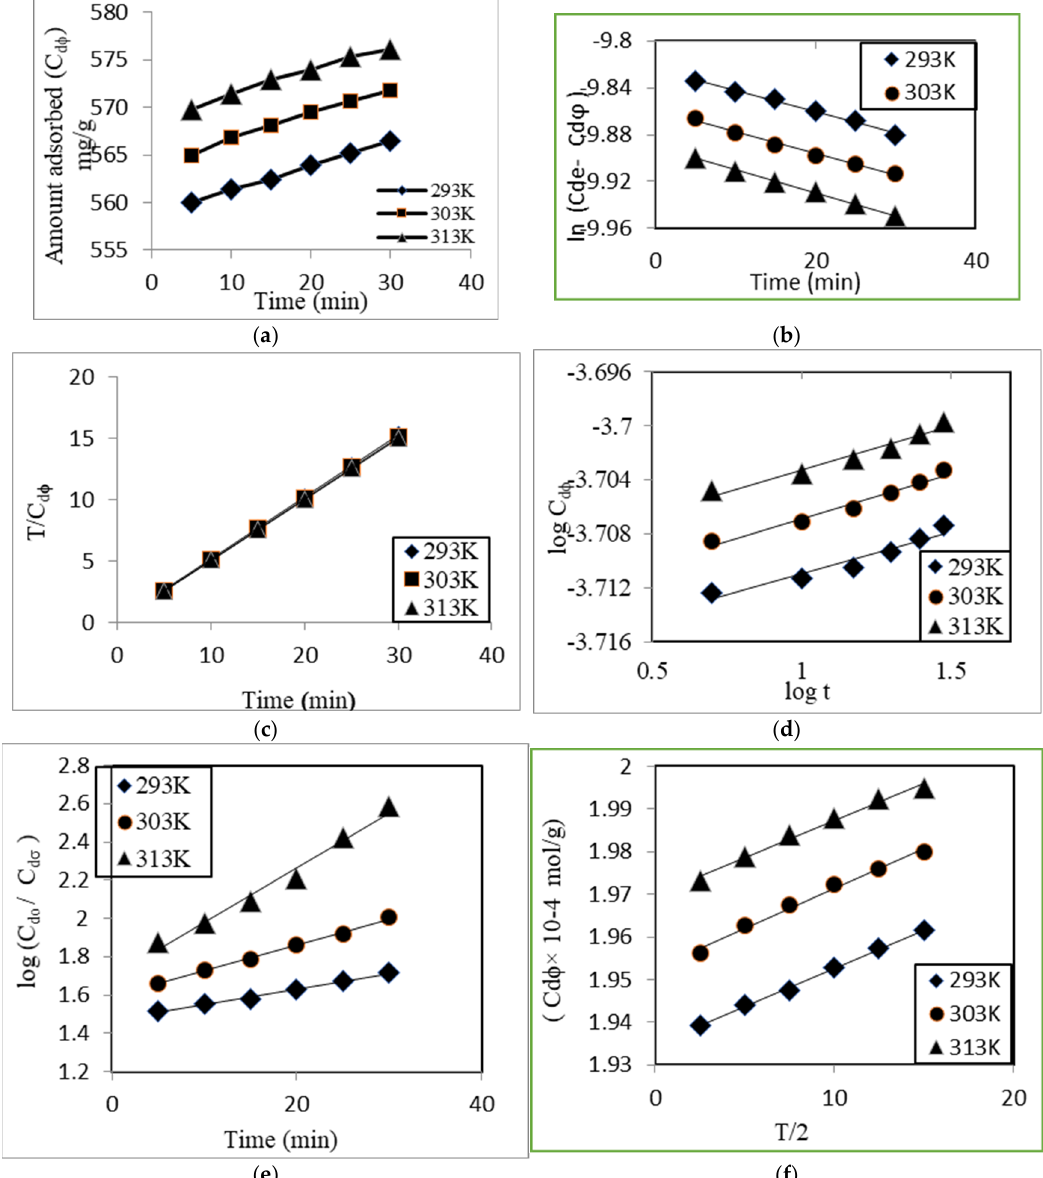
Figure 5. Basic Red 5 adsorption on SMPs. ( a ) Different temperatures, ( b ) Pseudo 1st order, ( c ) Pseudo 2nd order, ( d ) Power function, ( e ) Natarjan and khalaf, and ( f ) Intraparticle diffusion.